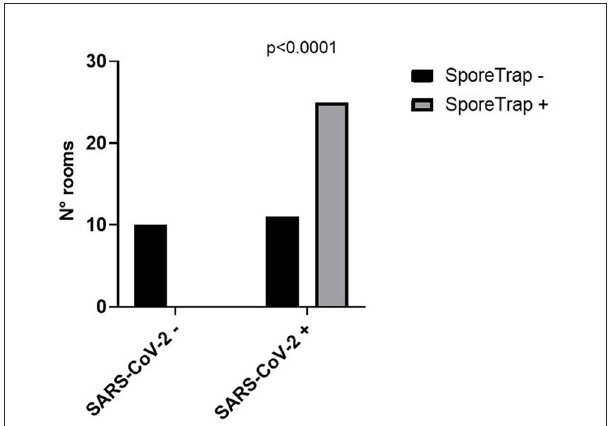
FIGURE2 Performance of the SporeTrap device in detecting the presence of Severe Acute Respiratory Syndrome Coronavirus 2 (SARS-CoV-2) in contaminated (SARS-CoV-2 + ) and non-contaminated (SARS-CoV-2 -) hospital rooms.